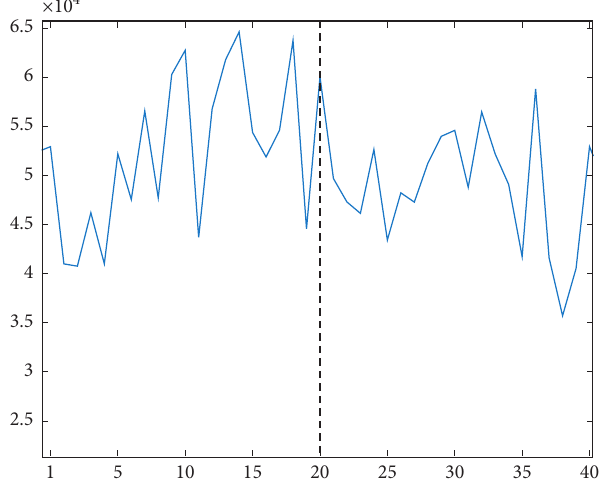
Figure 3: The changes in the daily selling order volume for the IC dominant